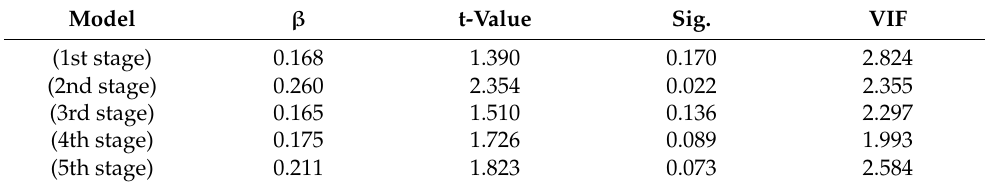
Table 7. Hypothesis